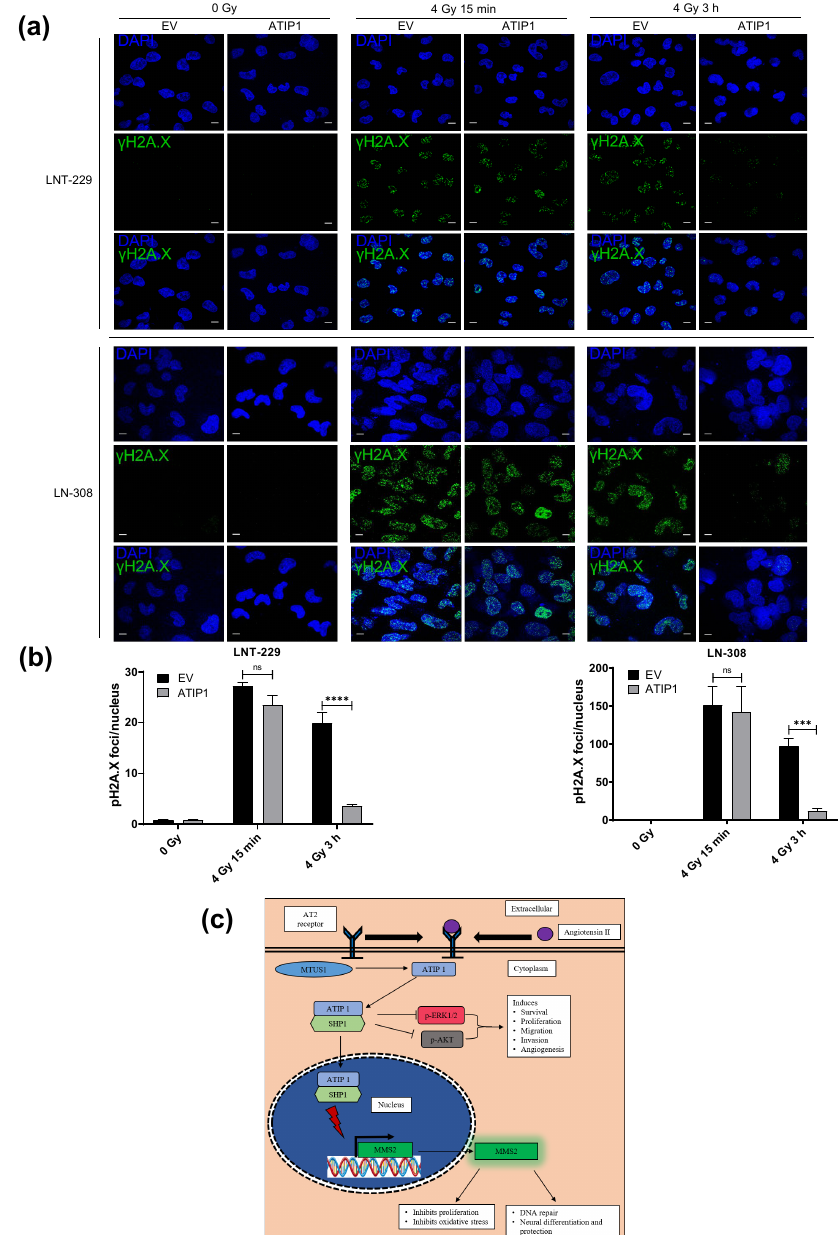
Figure 6. In glioma cells ATIP1 expression enhances the repair of irradiation-induced DNA damage. ( a ) γ H2A.X foci formation in control (0 Gy) and irradiated (4 Gy) pcDNA3.1 (EV) and pcDNA3.1-ATIP1 (ATIP1) stably transfected LNT-229 and LN-308 cells at the illustrated time points (scale = 100 µ m). ( b ) Quantification of γ H2A.X foci per nucleus (n = 9, SEM; ns: not significant, *** p < 0.001, **** p < 0.0001). ( c ) A simplified model of the role of ATIP1 in tumor